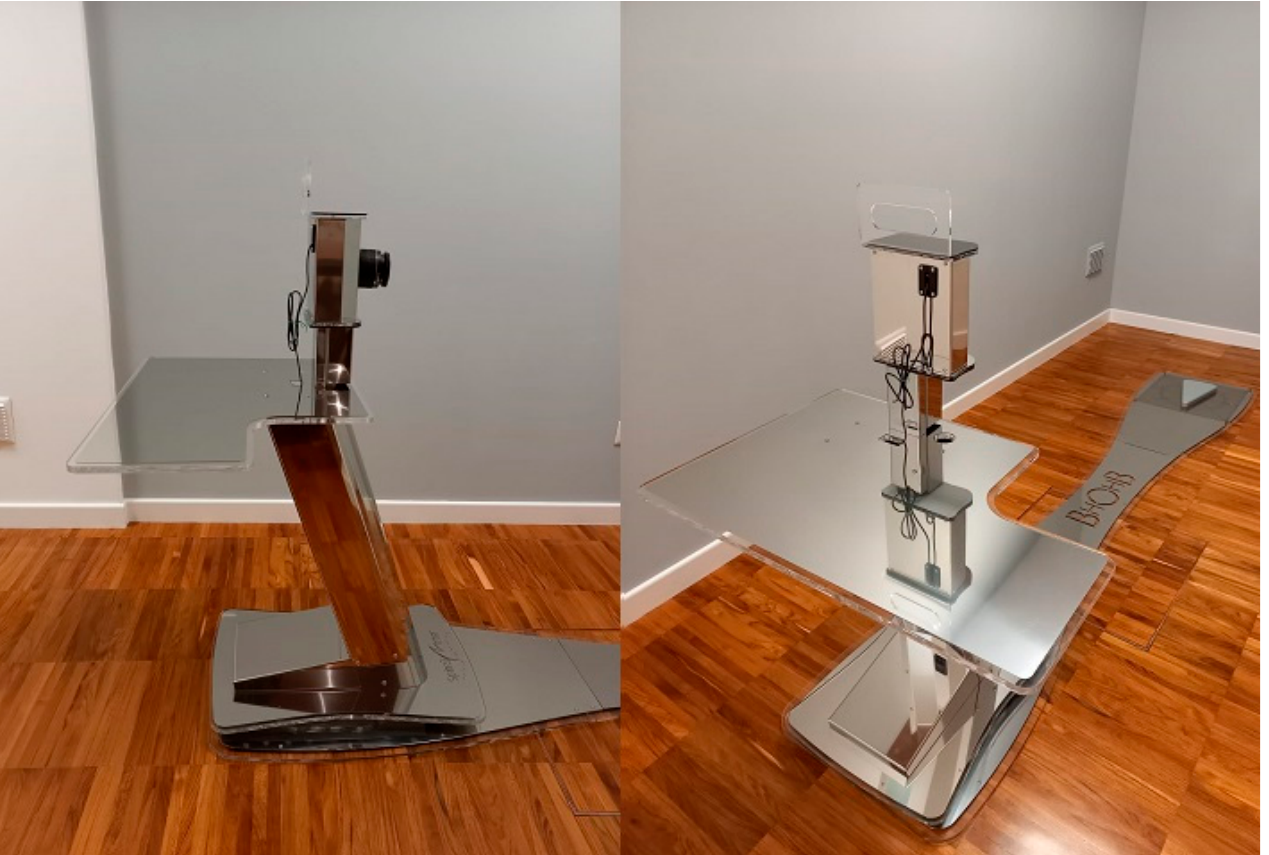
Figure 1. Biometrical Holistic Of Human Body (BHOHB) machine.